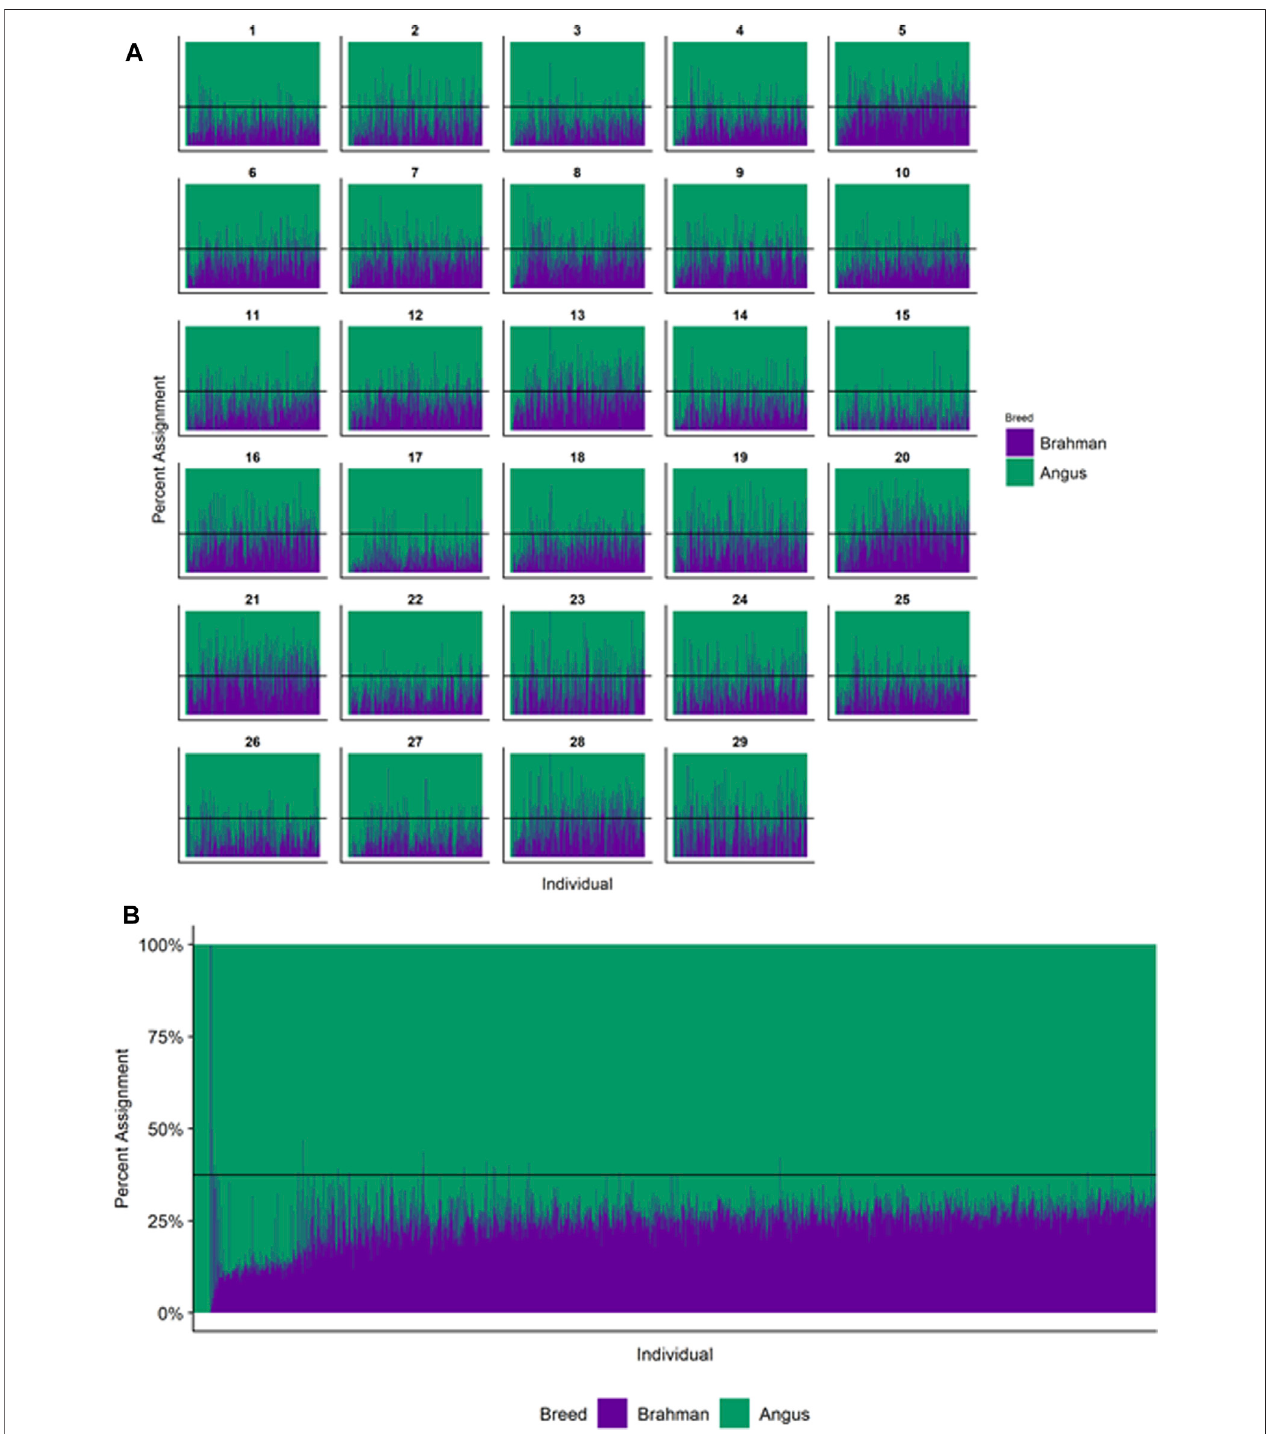
FIGURE4| Ancestry estimated by RFMix foreach Brangus individualplottedwith animals sorted bytotal number ofhaplotypes. (A) Ancestry assignmentfor each chromosome, and (B) Genome-wide ancestry. Individuals are represented by vertical bars within each plot with Brahman proportion in purple and Angus proportion in green. Animals to the left on the X -axes have the fewest number of haplotypes predicted within their genomes. The black line represents the expected proportion of 3/8 Brahman.